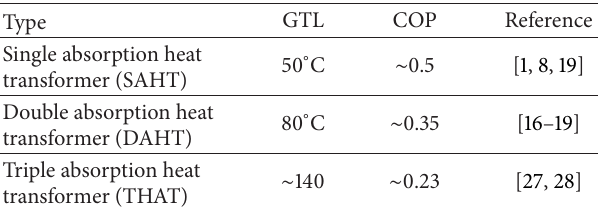
Table 1: System performances of different types of absorption heat